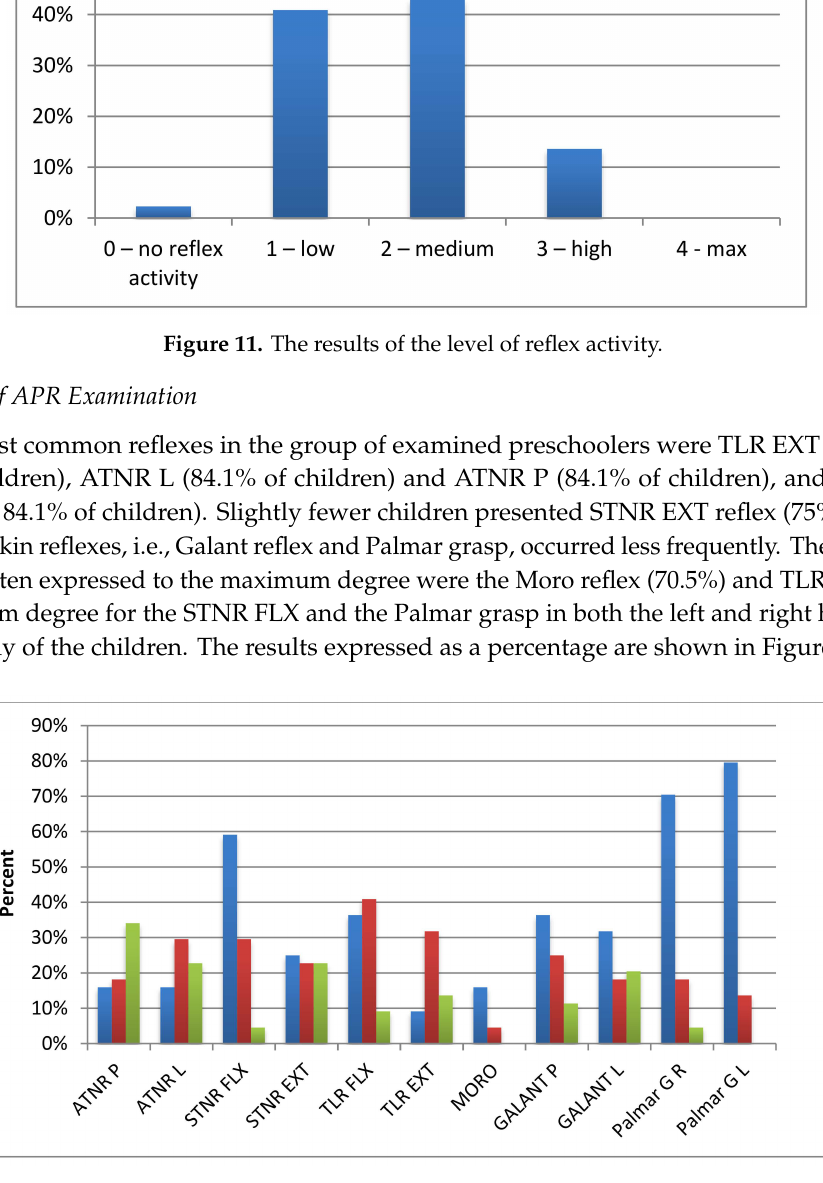
Figure 12. Results of the reflex test on a 0–2